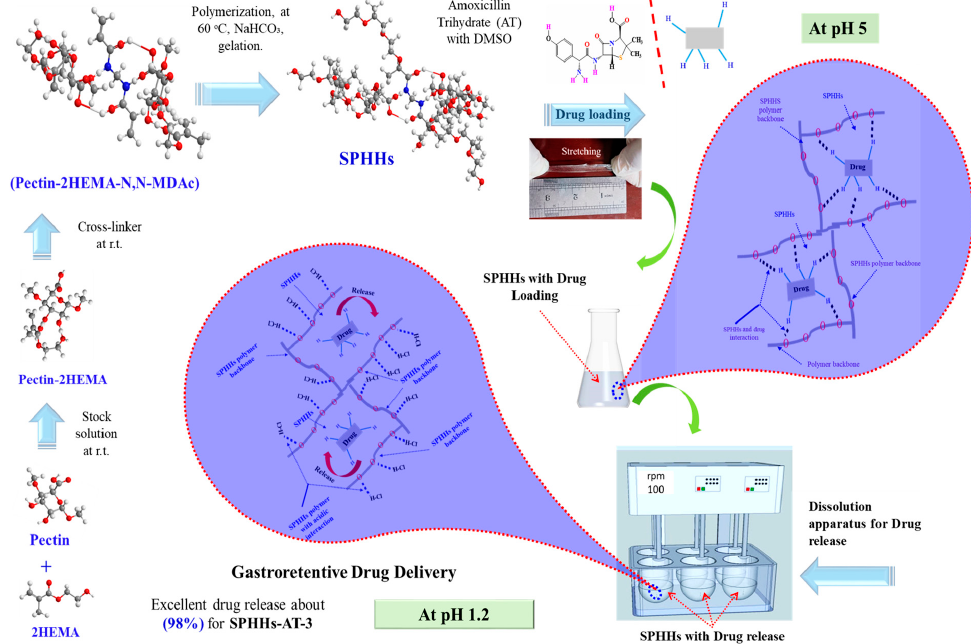
Figure 1. The probable synthesis ball-and-stick model of SPHHs and drug (AT, amoxicillin trihydrate) loading into SPHHs at pH 5 concerning SPHHs-AT and release at pH 1.2 in acidic conditions.